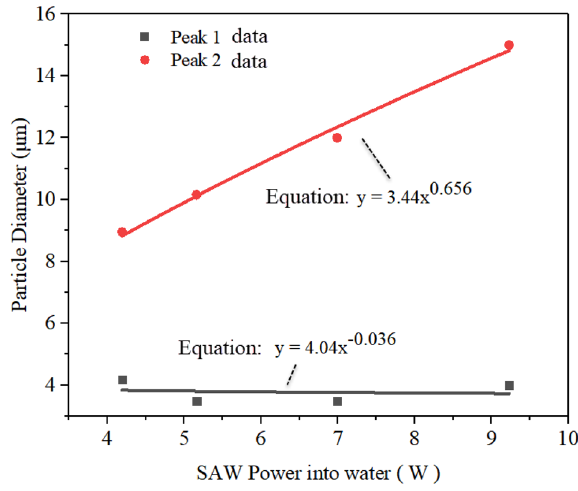
Figure 7. Experimentally measured aerosol size distribution under different SAW powers for each of the two peaks.